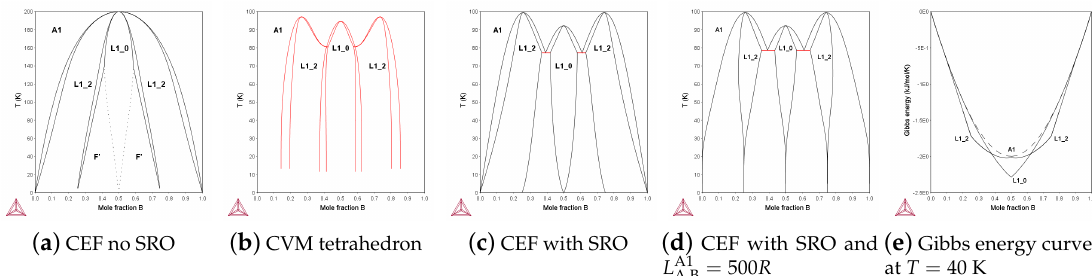
Figure 4. These phase diagrams have been calculated with a single bond energy parameter u AB = − 100 R . ( a ) The CEF model without SRO is used (as by Shockley), in ( b ) a tetrahedron CVM model and in ( c ) a CEF model with SRO according to Equation (14). Note also that the T axis in ( a ) is double that in ( b )–( d ). In ( d ) and ( e ) a configuration independent parameter has been